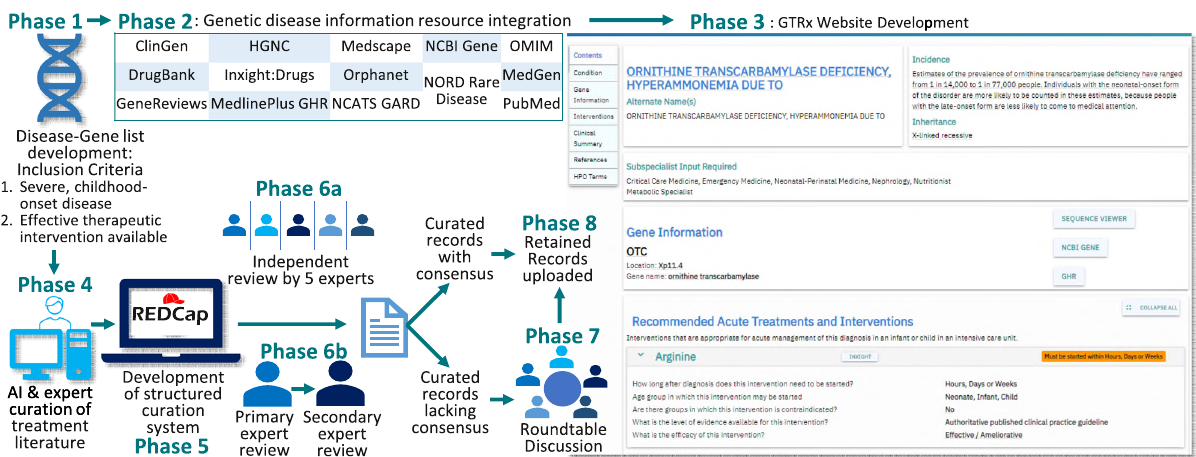
Fig. 2 Flowchart of the development of Genome-To-Treatment (GTRx), a virtual system for acute management guidance for rare genetic diseases. Phase 1 - Compilation of a comprehensive gene-genetic disease list for severe, childhood-onset conditions in which an established treatment was available. Phase 2, integration of 13 information resources pertaining to rare genetic diseases. Phase 3, development of the GTRx web resource containing the integrated information resources. Phase 4, automated, arti fi cial intelligence (AI)-based searching and manual curation of published evidence of treatments for each condition by three companies. Phase 5, development of a custom REDCap system for structured assessment of genes, disorders, and therapeutic interventions. Phase 6a, independent manual review of curated interventions and assertions for the fi rst 15 pilot gene-disease pairs by fi ve experts. Phase 6b, primary and secondary reviews of the remaining gene-disease pairs. Phase 7, round-table discussion of records lacking consensus. Phase 8, upload of retained consensus records to the GTRx web